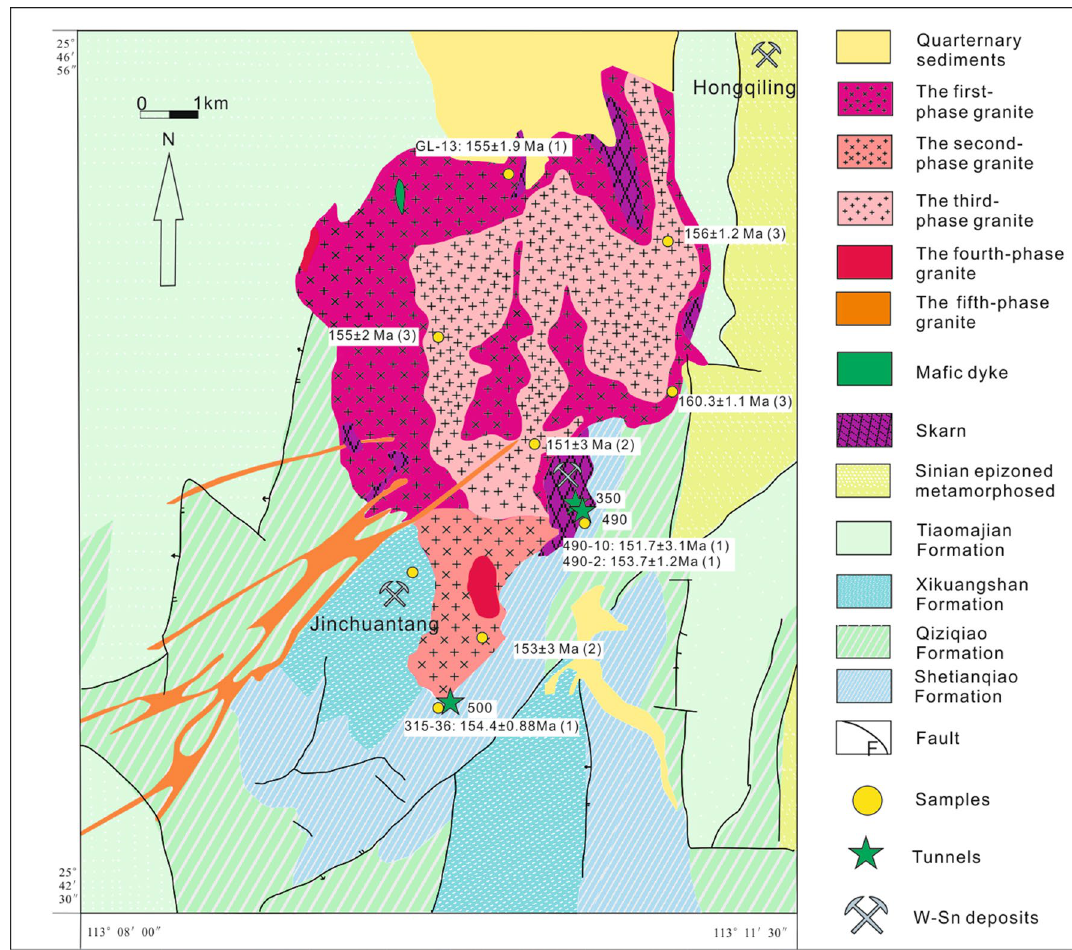
Figure 2. Schematic geological map of the Qianlishan district showing the QGC (modified after Chen et al. (2016) 14 , copyright@ Elsevier, 2016). The sample location and the obtained dates: ( 1 ) zircon LA-ICP-MS U–Pb dates from this study; (2) zircon SHRIMP U–Pb dates from Li et al. (2004) 28 ; and ( 3 ) zircon LA-ICP-MS U–Pb dates from Chen et al. (2014) 13